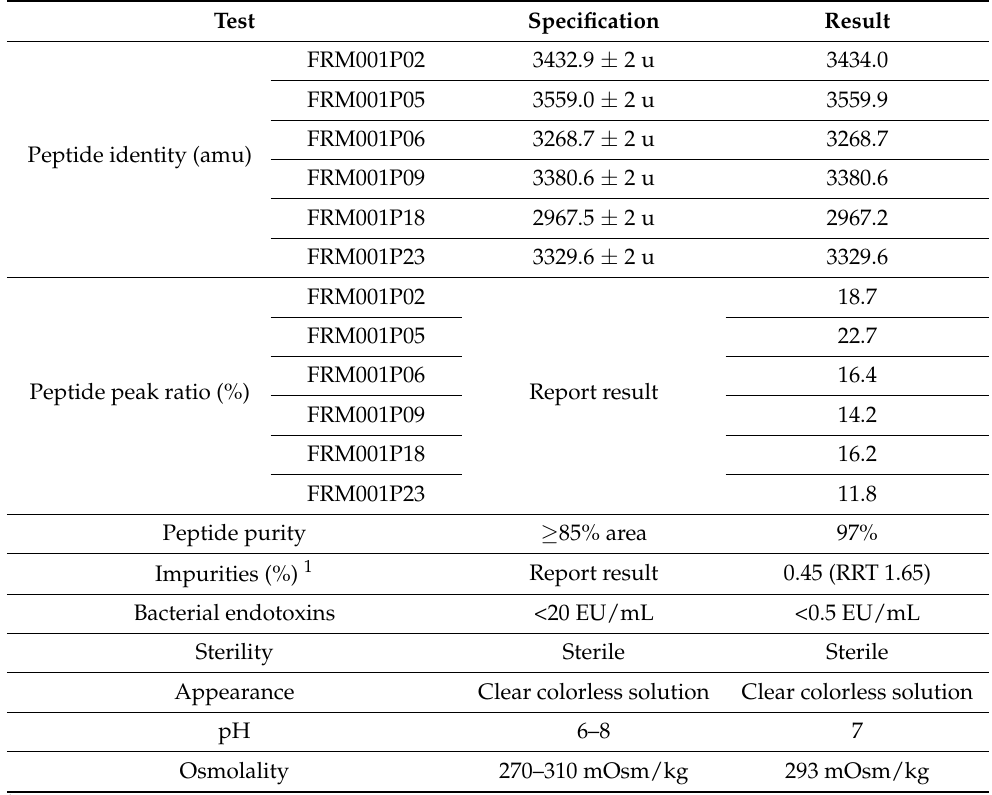
Table 6. The tests results of peptide mixture FRM001-M3 that was manufactured under GMP conditions.